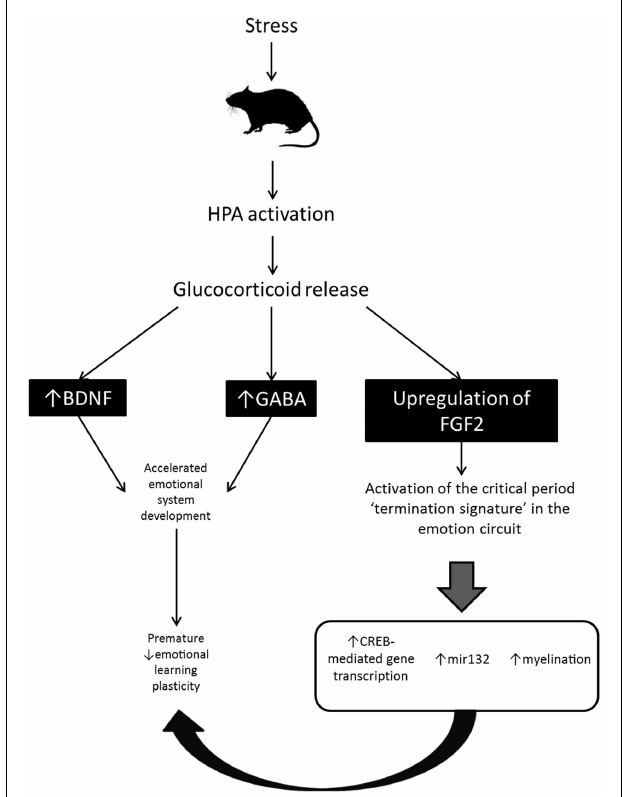
FIGURE 2 | Proposed mechanism by which chronic stress accelerates the developmental transition between infant and adult-like forms of fear retention and fear learning in rodent models . Stress-induced activation of the HPA axis results in increased BDNF and GABA, and central upregulation of FGF2. BDNF and GABA stimulate early development of the emotion system and may lead to early opening of the critical period for infantile amnesia and erasure-like extinction. FGF2 upregulation triggers activation of the critical period “termination signature” in the emotion circuit (i.e., activates the cellular and molecular mechanisms known to be involved in critical period timing in sensory systems). Activation of those signals leads to an early termination of fear learning